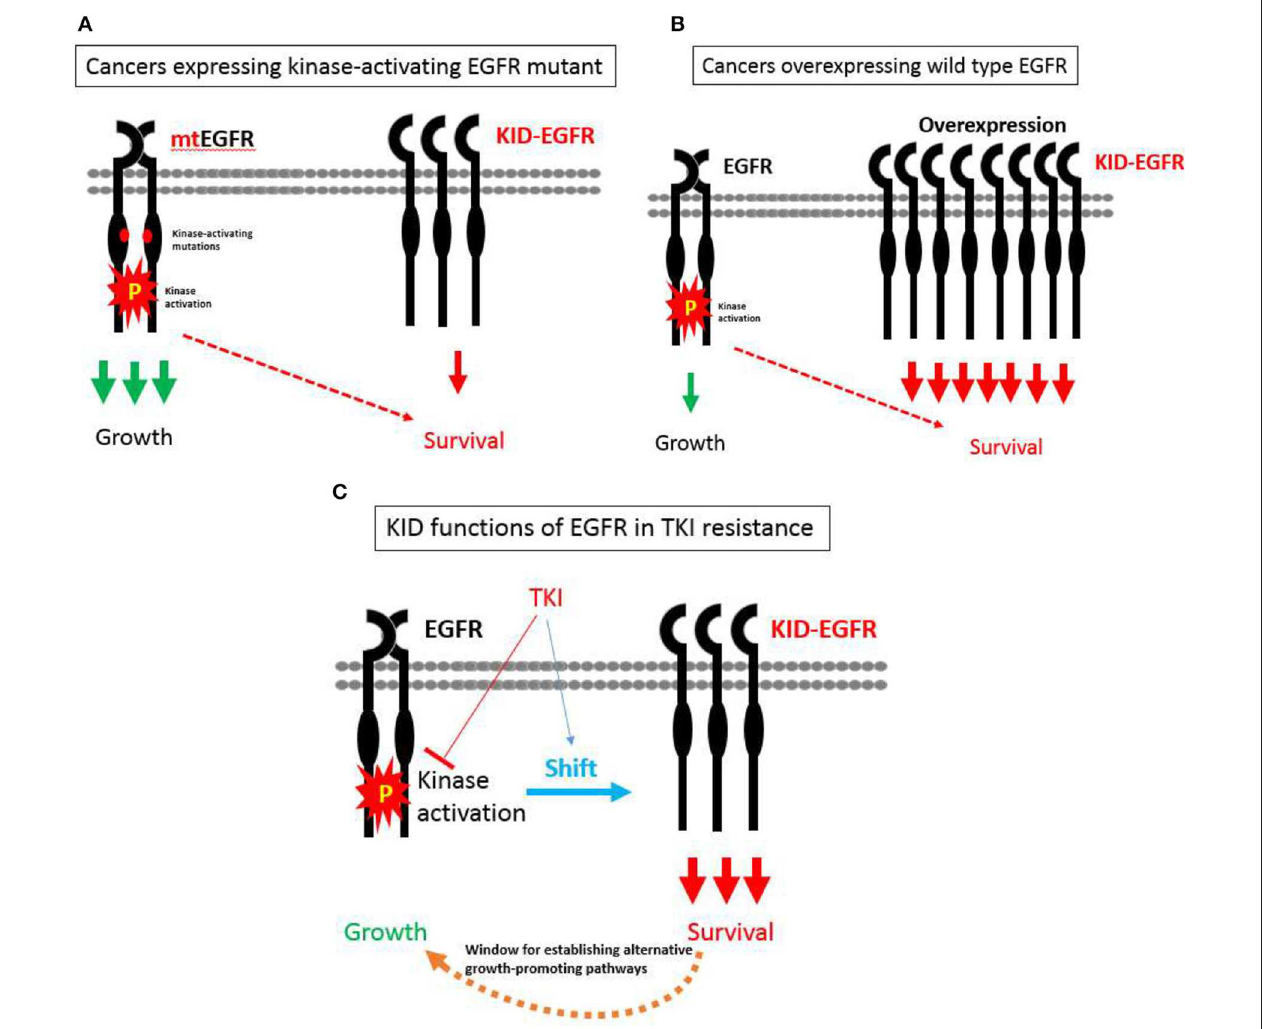
FIGURE 3 | A hypothesis pertaining to EGFR’s divergent roles in regulating growth vs. survival of cancer cells in relevant to TKI resistance. (A) In cancer cells expressing kinase-activating mutations, the role of EGFR is shifted toward its kinase-dependent functions, which sensitizes these cancers cells to TKI. (B) In cancer cells over-expressing wild type EGFR, the role of EGFR is shifted toward its kinase-independent functions, which promotes the progression of cancers rather desensitizes these cancers to TKI. (C) At situation of TKI treatment, the role of EGFR is also tilted toward its kinase-independent functions that allows cancer cells to survive and develop alternative growth-promoting mechanisms to counteract with TKI’s inhibitory